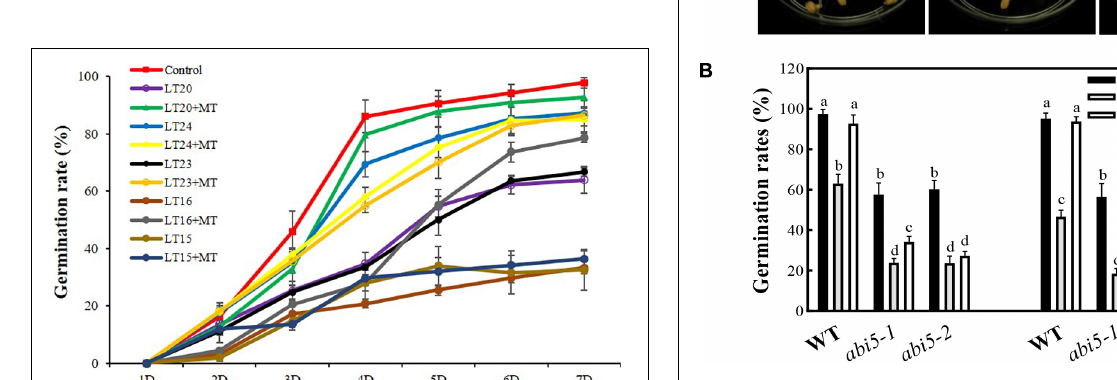
FIGURE 1 | Germination rates of rice seed germination during different low-temperature (LT) stress conditions in the presence or absence of melatonin (MT) treatment. Exogenous applications of MT (150 mM) were employed to provide treatment for rice seeds under different LT stress conditions for 7 days. Control: constant 30 ◦ C; LT15: constant 15 ◦ C; LT20: constant 20 ◦ C; LT24: constant 24 ◦ C.